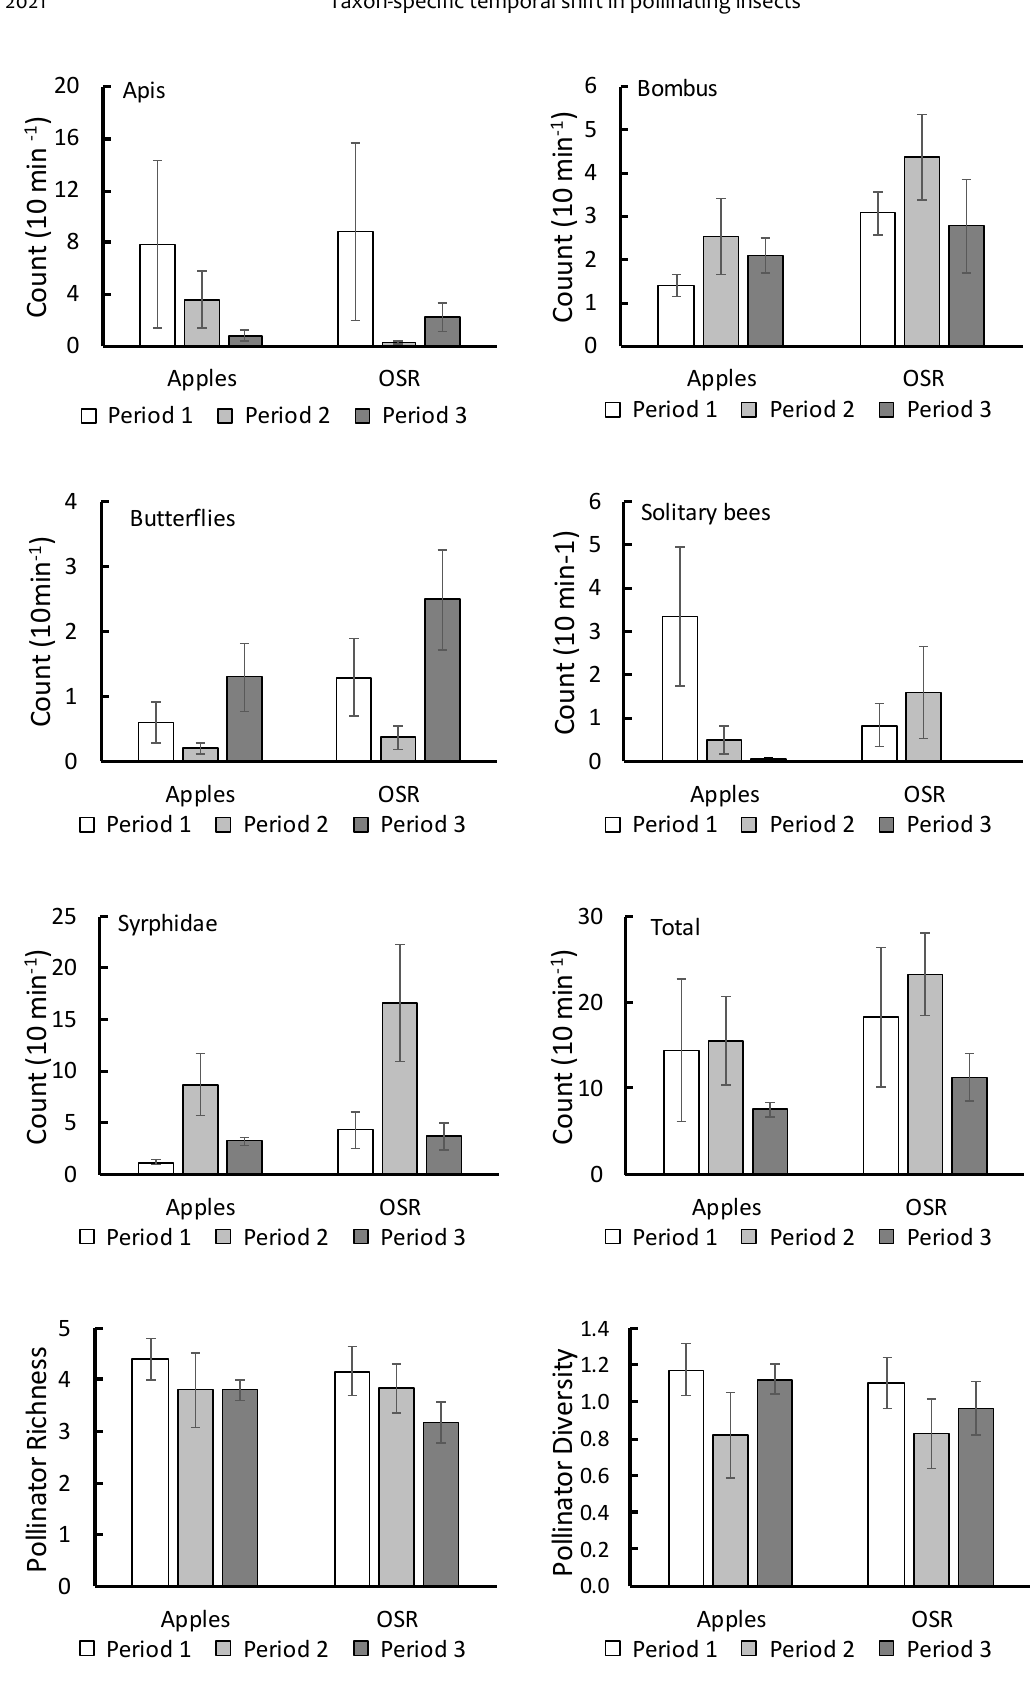
Figure 4. Abundance (mean ± SE) of pollinating insects in field margins during the flowering period (Period 1), 1-month after flowering (Period 2) and 3-months after flowering (Period 3) in OSR ( n = 6) and apples ( n =